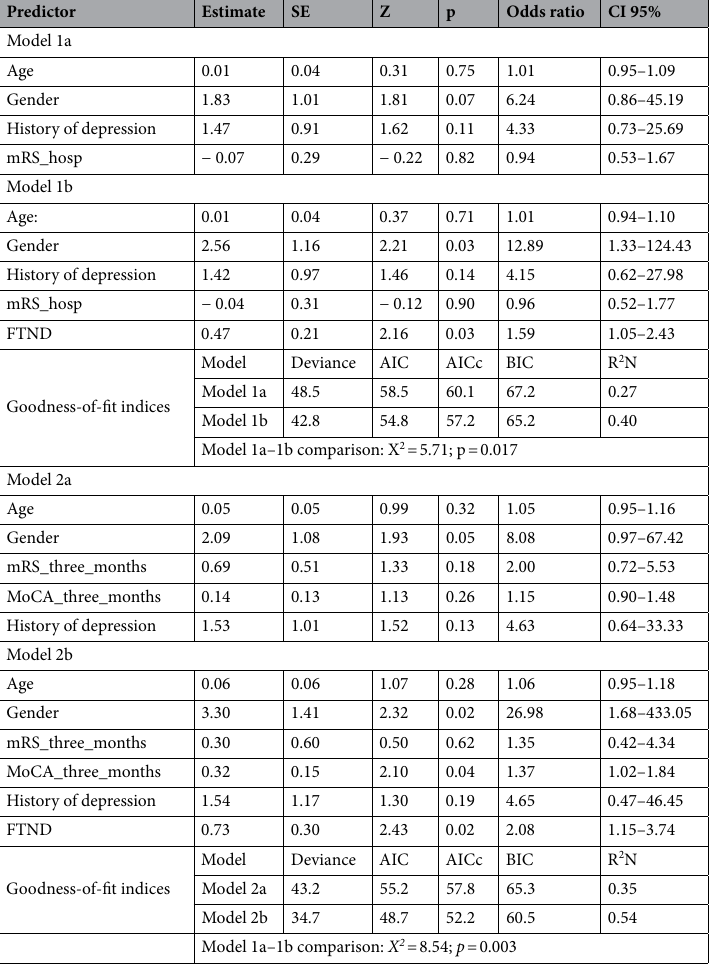
Table 4. Predictors of three months post-stroke depression among patients with a problematic tobacco use. Model 1. Impact of hospitalization variables on the prediction of post-stroke depression category before (1a) and after (1b) taking into account the baseline level of tobacco dependence. Model 2. Impact three months follow-up variables on post-stroke depression category before (2a) and after (2b) taking into account the level of tobacco dependence. FTND Fagerström Test for Nicotine Dependence, MoCA Montreal Cognitive Impairment, NIHSS National Institutes of Health Stroke Scale, mRS_hosp baseline modified Rankin Scale collected at the end of